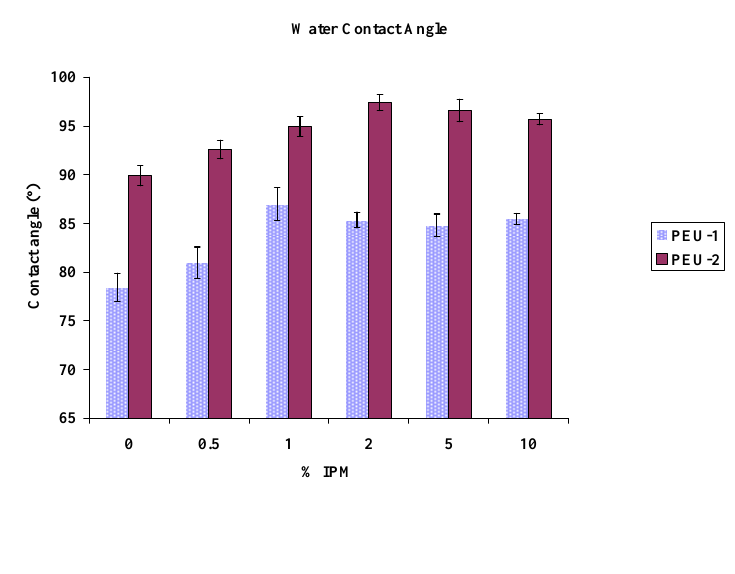
Figure 7. Water contact angle of IPM modified